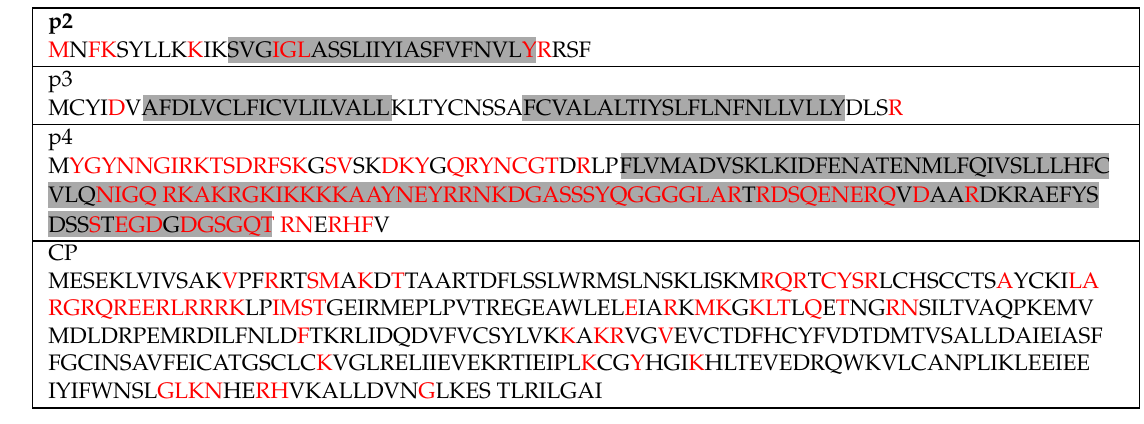
Table 2. RNA interacting amino acid residues predicted in Ribes americanum virus A proteins. Amino acid residues in red color are predicted to interact with RNA. Shaded regions are predicted transmembrane domain(s) in p2 and p3 proteins whereas in p4 it indicates the region aligned to the helicase domain of ATP-dependent DNA